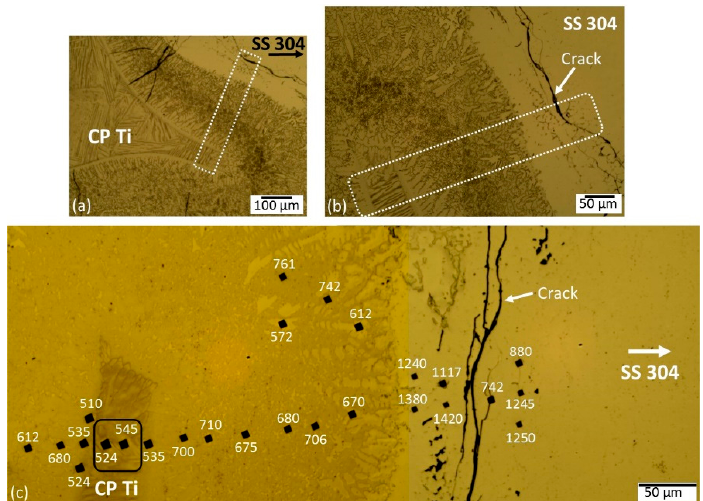
Figure 4. Optical micrographs of GTAW showing ( a ) low magnification and ( b ) higher magnification of the “weld zone” with the dashed line box indicating the area of interest for hardness measurements, chemical composition analysis and phase identification, and ( c ) the hardness distribution within the dashed line box area. Note that hardness values around the cracks are comparable to those adjacent to the fracture surface area, i.e., 970 to 1300 HV.